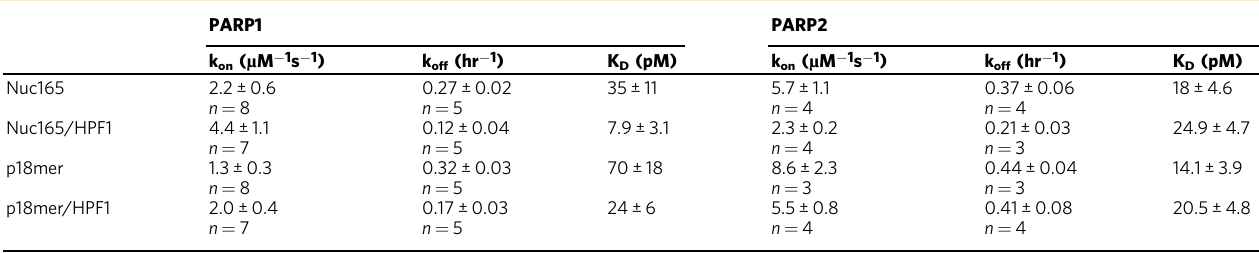
Table 2 Kinetic and thermodynamic parameters for the binding of fl -Ola to PARP1 and PARP2.